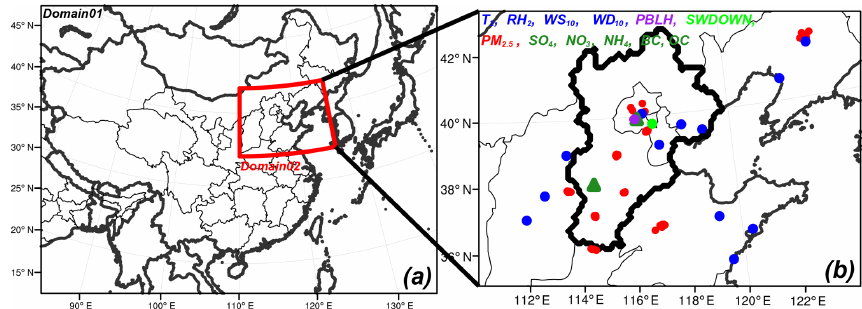
Figure 1. (a) Map of the two nested model domains. (b) Locations of the observations used for model evaluation.